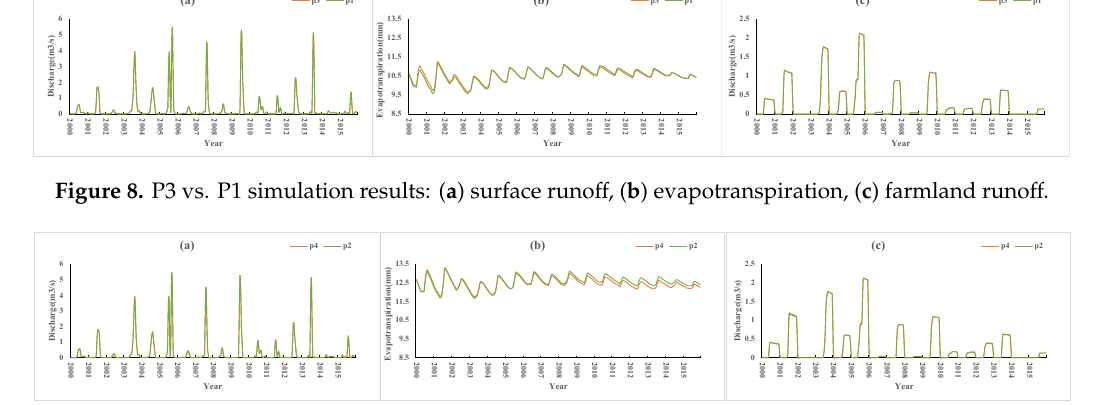
Figure 9. P4 vs. P2 simulation results: ( a ) surface runoff, ( b ) evapotranspiration, (c) farmland runoff.